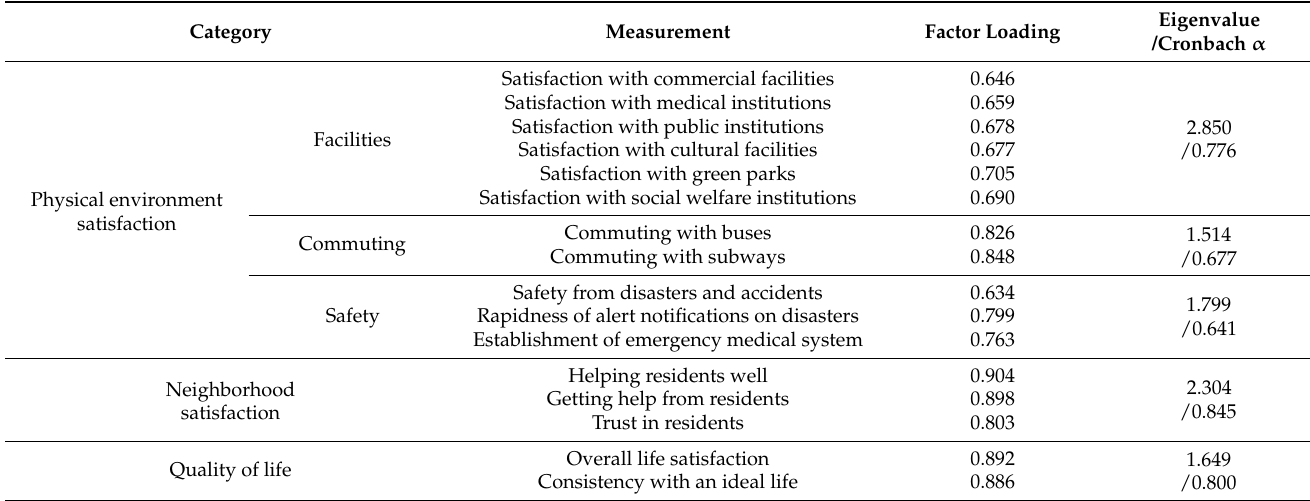
Table 2. Exploratory factor analysis (EFA) and reliability